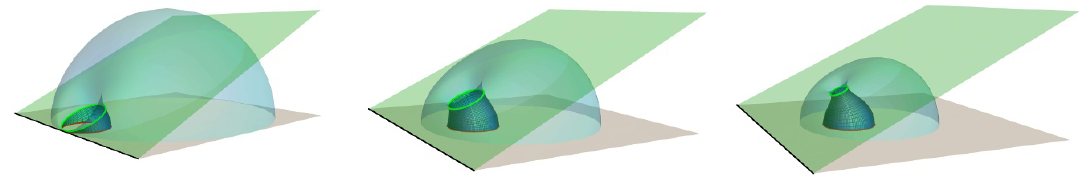
Figure 11 . Extremal surfaces ^ (cid:13) con anchored to a disk (bounded by the red circle) of radius R at A (cid:12)nite distance d from the (cid:13)at boundary, like in (cid:12)gure 10. Here (cid:11) = 2 : 7 is (cid:12)xed (like in the right panel of (cid:12)gure 10) and the di(cid:11)erent values of d=R are considered: d=R (cid:24) 0 : 042 (left), d=R (cid:24) 1 : 6 (middle) and d=R (cid:24) 2 : 243 (right). The shaded surfaces correspond to ^ (cid:13) con and for all the con(cid:12)gurations of A; aux this (cid:12)gure part of ^ (cid:13) con belongs to the gravitational spacetime (2.21) (see also appendix D). The A; aux extremal surface ^ (cid:13) con is a global minimum when its F A is larger than 2 (cid:25) . The con(cid:12)guration in A; aux the left panel is the same shown in the right panel of (cid:12)gure 10. In the remaining panels F A = 6 : 95 (middle) and F A = 6 : 13